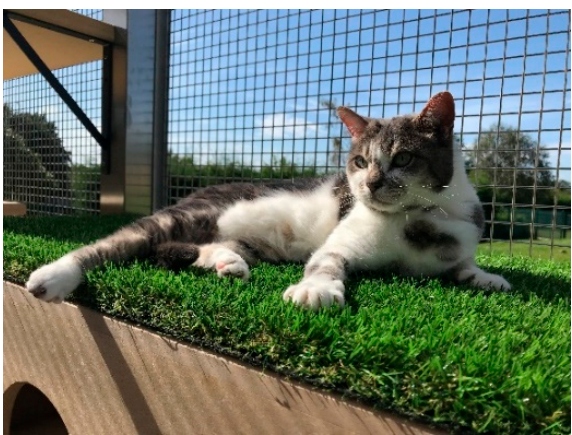
Figure 5. A cat resting on an AstroTurf-covered shelf in the enclosed catio area at